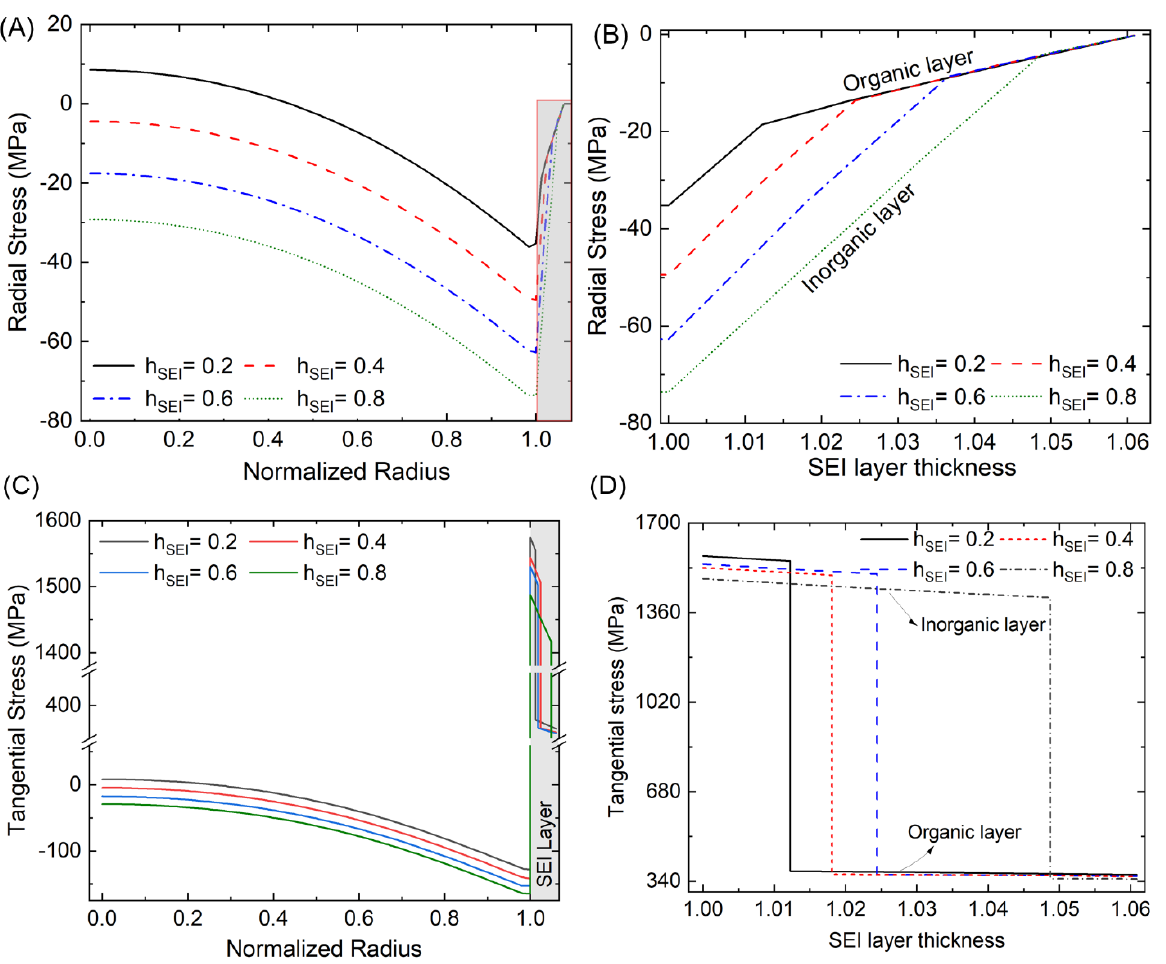
Figure 5. Effect of h SEI on radial and tangential stress inside the particle and SEI layer during lithiation. The results are plotted for 2000 cycles. ( A ) Radial stress inside the particle and SEI layer, with ( B ) magnified view inside the inorganic and organic SEI layer. ( C ) Tangential stress inside the particle and SEI layer, with ( D ) magnified view of inside the inorganic and organic layers.